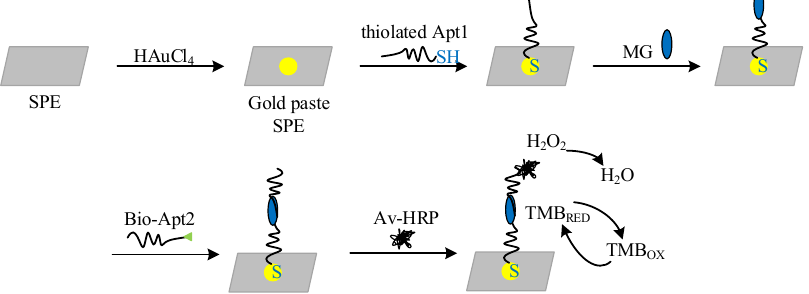
Figure 2. Schematic of the construction of the electrochemical DNA biosensor. SPE–screen printing electrode; MG–malachite green.